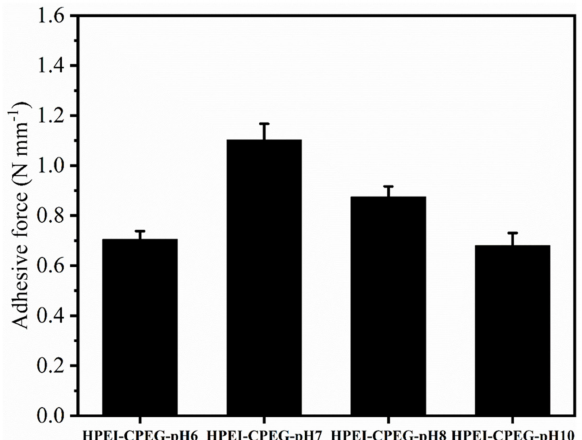
Figure 3. 180 ◦ peeling test results of Si electrodes based on HPEI-CPEG-pH6, HPEI-CPEG-pH7, HPEI-CPEG-pH8, and HPEI-CPEG-pH10